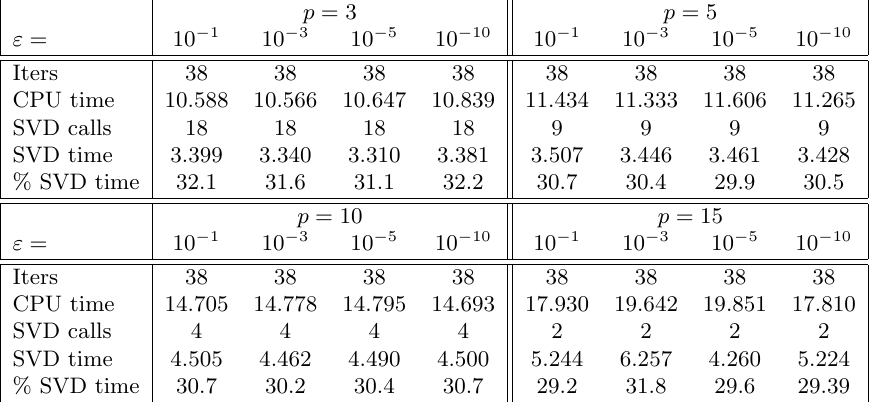
Table 3. Performance of the DBRR method for Problem 2.